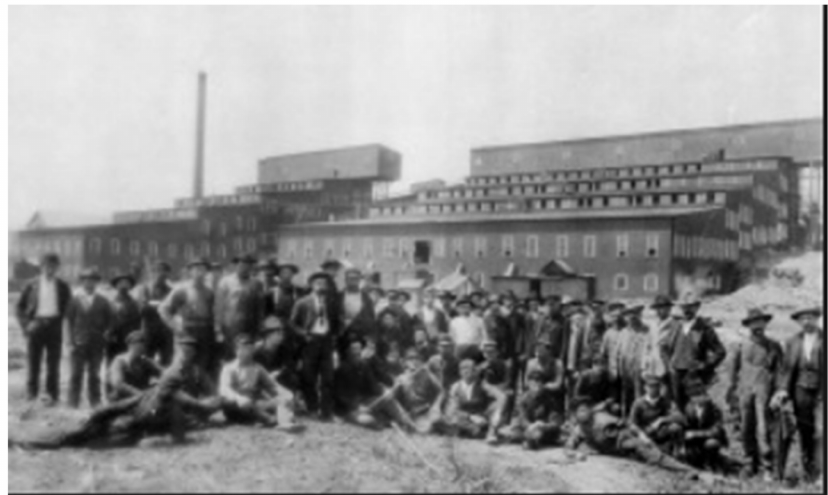
Figure 2. Workers from the Wolverine (left) and Mohawk (right) Mills. Stamp rock was delivered by railroad cars at the top level, and crushed by stamps and rollers in the interior. Stamp sands were sluiced out along a tailings launder onto the pile in the bay (undated photo; MTU Archives). Between 1902 to 1932, company records indicate that the two stamp mills at Gay sluiced 22.7 million metric tonnes (MMT = Terra-grams, Tg) of copper-rich ‘stamp sands’ onto a major tailings pile (Figure 3, “original pile”; [11–15]). As a cross-check on discharges, Babcock and Spiroff [16] recorded 22.6 MMT mill rock crushed at the two mills. Figure 3, a LiDAR DEM (Light Detection and Ranging, Digital Elevation Model), collected with a com- bination terrestrial topographic plus bathymetric LiDAR system (2010 NOAA CHARTS), highlights basic elevation and bathymetric details of the bay’s coastal